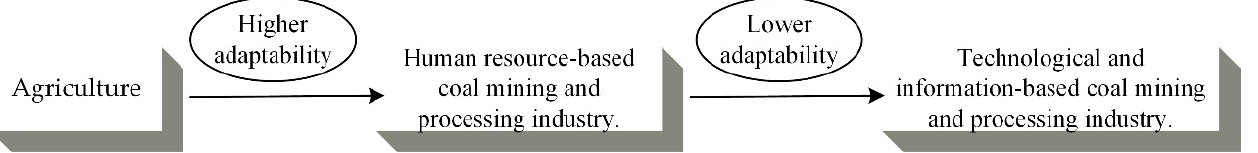
Figure 5. The adaptation of residents in the study area to changes in living or production patterns. (The contents were compiled from Yingui Cao’ doctoral dissertation and the policy documents pub- lished by the People’s Government of Shanxi Province (http://www.shanxi.gov.cn/ accessed on 18 De- cember 2021), and the figure was made by Shufei Wang.)